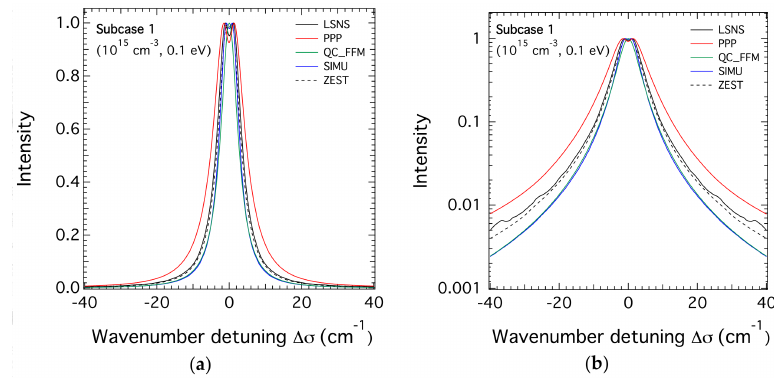
Figure 1. The theoretical Stark profiles of the H- β line calculated for hydrogen atoms in a helium plasma with an electron density of 10 15 cm − 3 and a temperature of 0.1 eV for both plasma He + ions and electrons. The profiles are centered at 486.1 nm and the wavenumber units are used; ( a ) linear scale. ( b ) semi-logarithmic